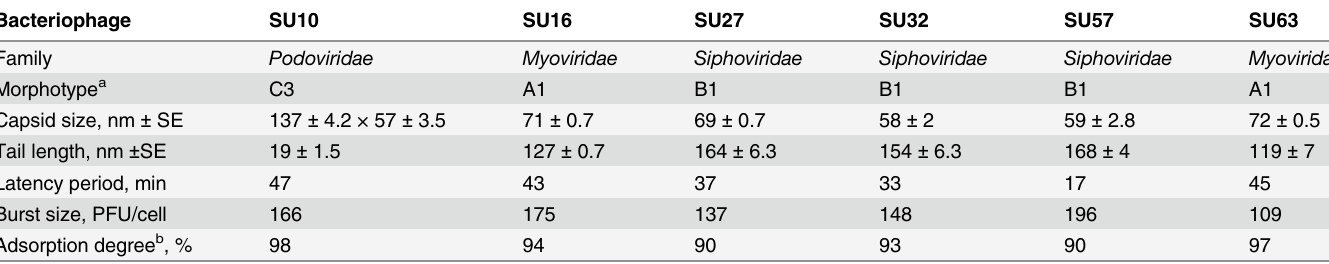
Table 1. Taxonomy, morphology and virulence data of the six bacteriophages.